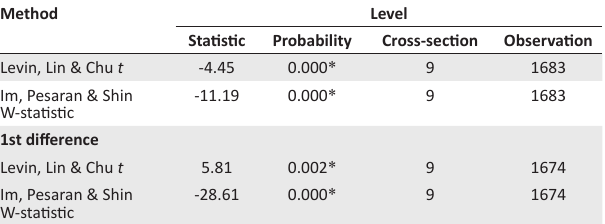
TABLE 3: Panel unit root test: Exchange rate level – with standard deviation.